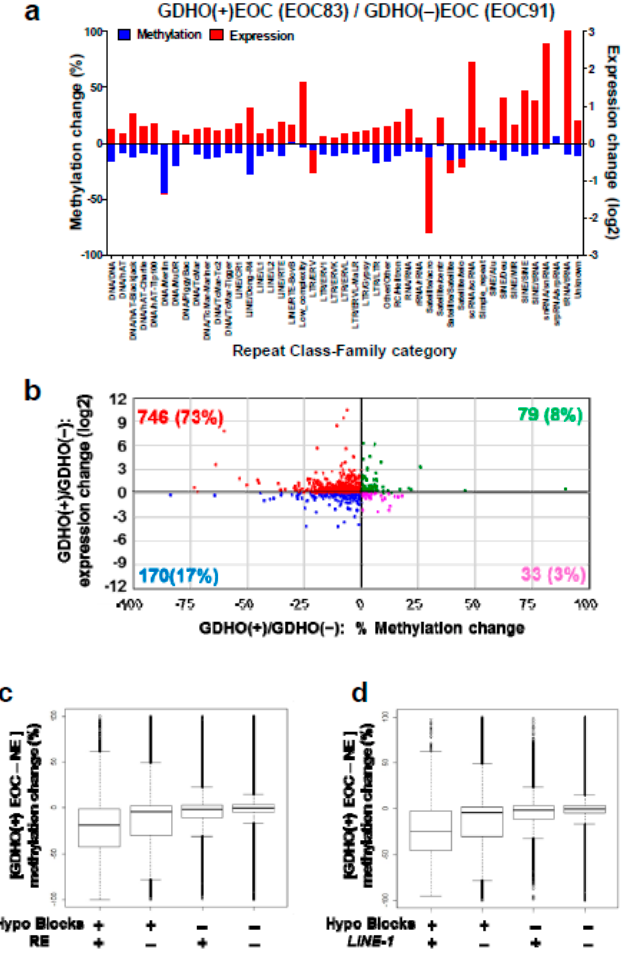
Figure 8. Overexpression of repetitive elements (RE) in GDHO ( + ) EOC. ( a ) Comparison of the expression and methylation of major sub-classes of REs in GDHO ( + ) vs. GDHO (–) EOC. Expression data were obtained from RNA-seq and methylation data from Methyl-seq. EOC83 and EOC91 are matched for stage and grade (stage 3C, grade 3). ( b ) RE expression vs. methylation in GDHO ( + ) vs. GDHO (–) EOC, using the same samples as in panel a . RE expression and methylation were determined by RNA-seq and Methyl-seq, respectively. Data points correspond to the average % methylation and log2 expression change across RE families. The results indicate that most RE families show increased expression and decreased methylation in GDHO ( + ) EOC. ( c ) DNA hypomethylation at hypomethylated blocks and / or all RE, in GDHO ( + ) as compared to NE, determined by Methyl-seq. ( d ) DNA hypomethylation at hypomethylated blocks and / or all LINE-1 elements, in GDHO ( + ) as compared to NE, determined by Methyl-seq. In c–d , the median + interquartile range values are indicated. These data suggest that global hypomethylation is driven by hypomethylated block formation rather than LINE-1